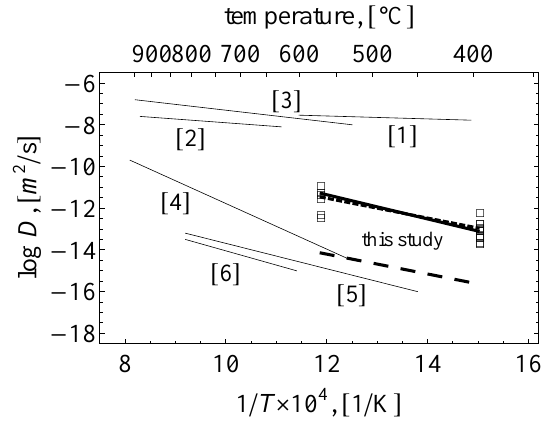
Figure 14. Diffusion coefficients constrained by the analyses per- formed in this study in comparison to previously reported values. Open squares represent the results from fitting individual grooves with the analytical groove shapes suggested by the Mullins’ theory (see also Fig. 12). The thick lines labeled “this study” represent the results from fitting sets of groove characteristics (see also Fig. 13, Eqs. 3 and 4 with kinetics data from Table 3; solid line: surface diffusion through fluid volume; dotted line: diffusion through fluid volume; dashed line: diffusion through crystal). Thin solid lines re- fer to literature values: [1] Stokes–Einstein relation for 1GPa (Wat- son and Wark, 1997); [2] SiO 2 diffusivity at 1GPa (Watson and Wark, 1997); [3] diffusion of Si(OH) 4 in bulk water at 900 ◦ C, 500MPa (Doltsinis et al., 2007a); [4] grain boundary diffusion of SiO 2 constrained by growth rates of wollastonite rims observed in contact metamorphic rocks (Joesten and Fisher, 1988); [5] hy- drothermal grain boundary diffusion of O (Farver and Yund, 1991); [6] hydrothermal grain boundary diffusion of Si for 600 to 800 ◦ C, 150MPa (Farver and Yund,